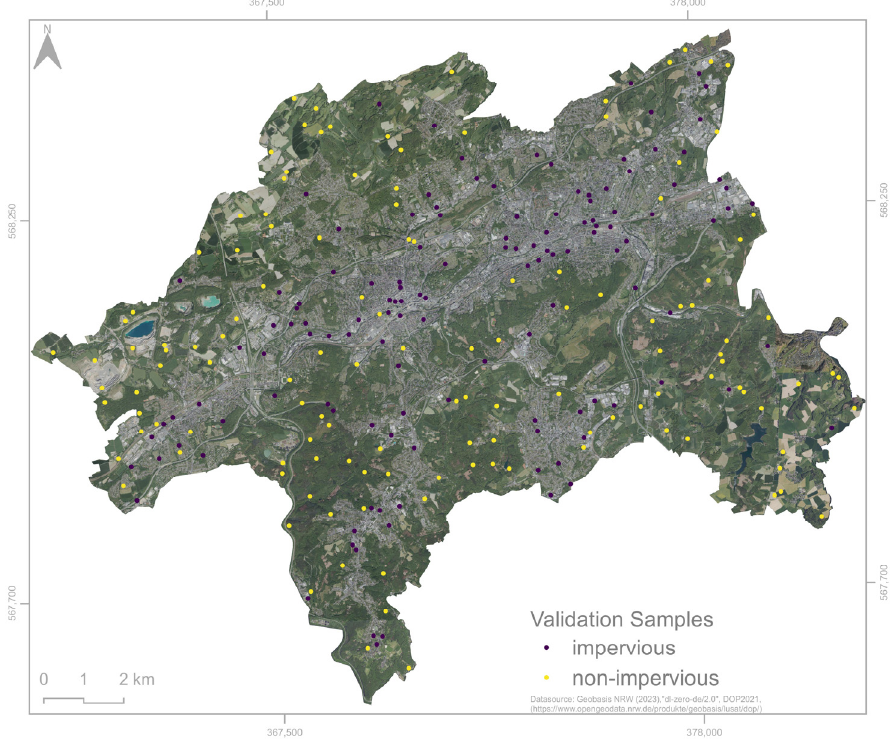
Figure 5. Distribution of generated validation samples in the study area.